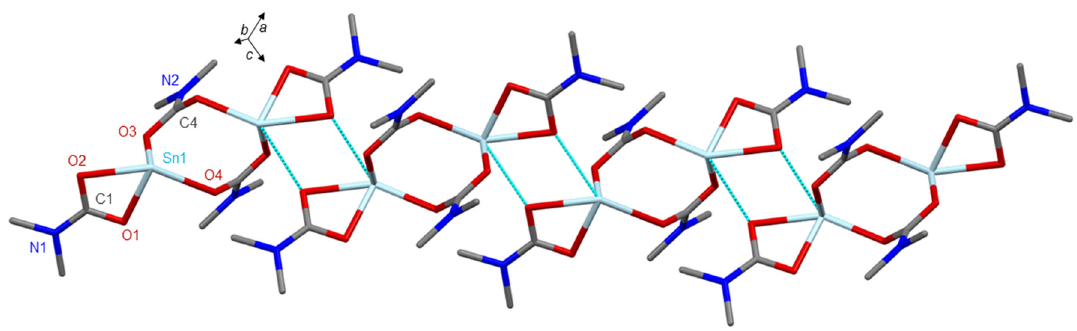
Figure 4. Molecular structure of 5 , adapted from [52] (MERCURY view). Hydrogen atoms are omitted for clarity (Sn light blue, O red, N dark blue, C grey). Intermolecular hydrogen bonds are shown by cyan dash lines.